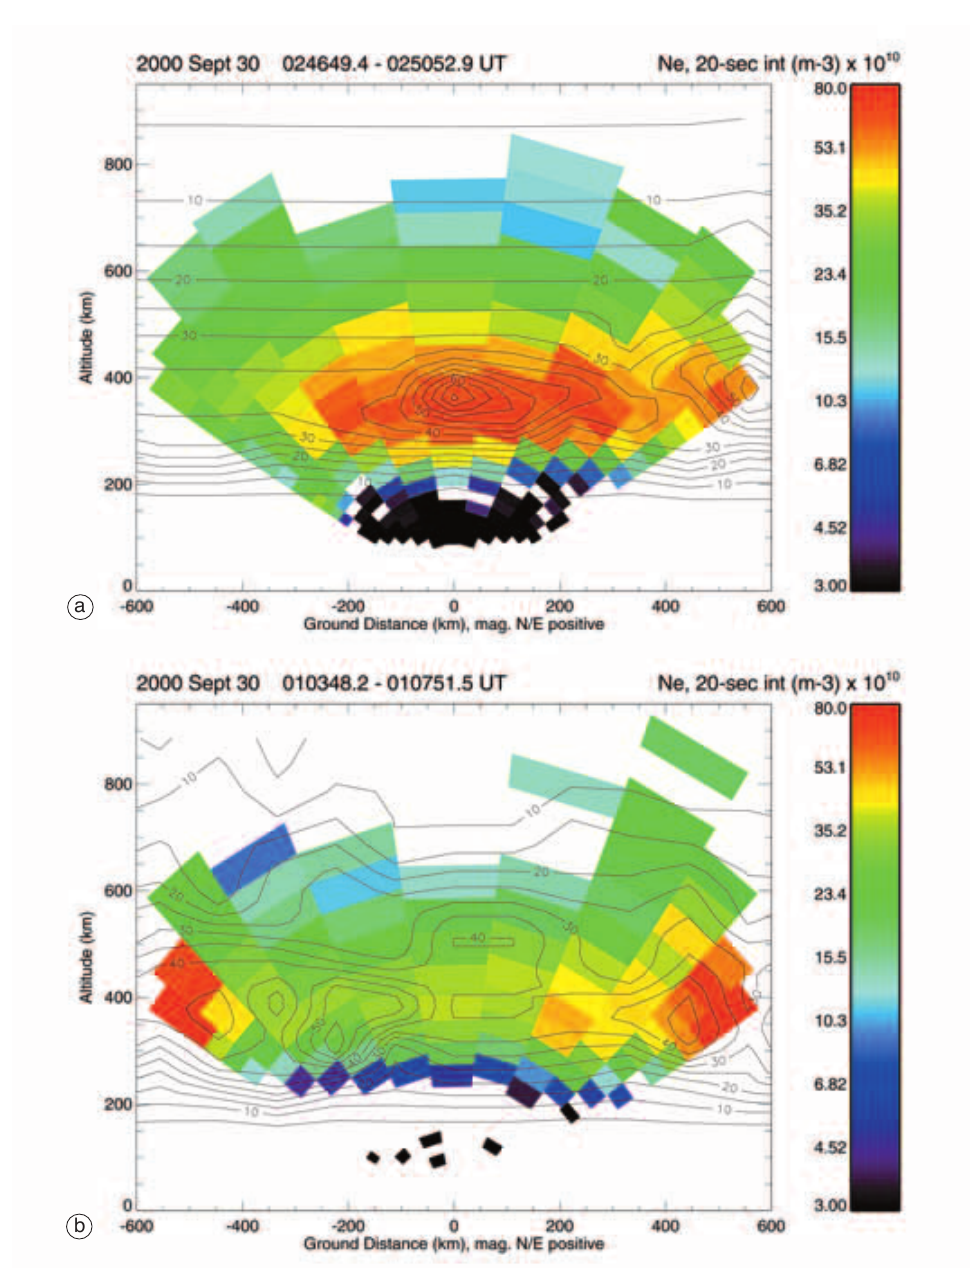
Fig. 3a,b. a) Electron density map from ISR measurements in the vertical plane of the antenna scan which lasted from 024649 UT through 025052 UT, and tomographic image reconstructed in the same reference plane as the antenna scan, centered on 0247 UT. 0 km ground distance and 0 km range refer to the Sondrestrom ISR site (STF). b) as (a) but for the 010348-010751 UT radar scan and the 0106 UT tomographic image,